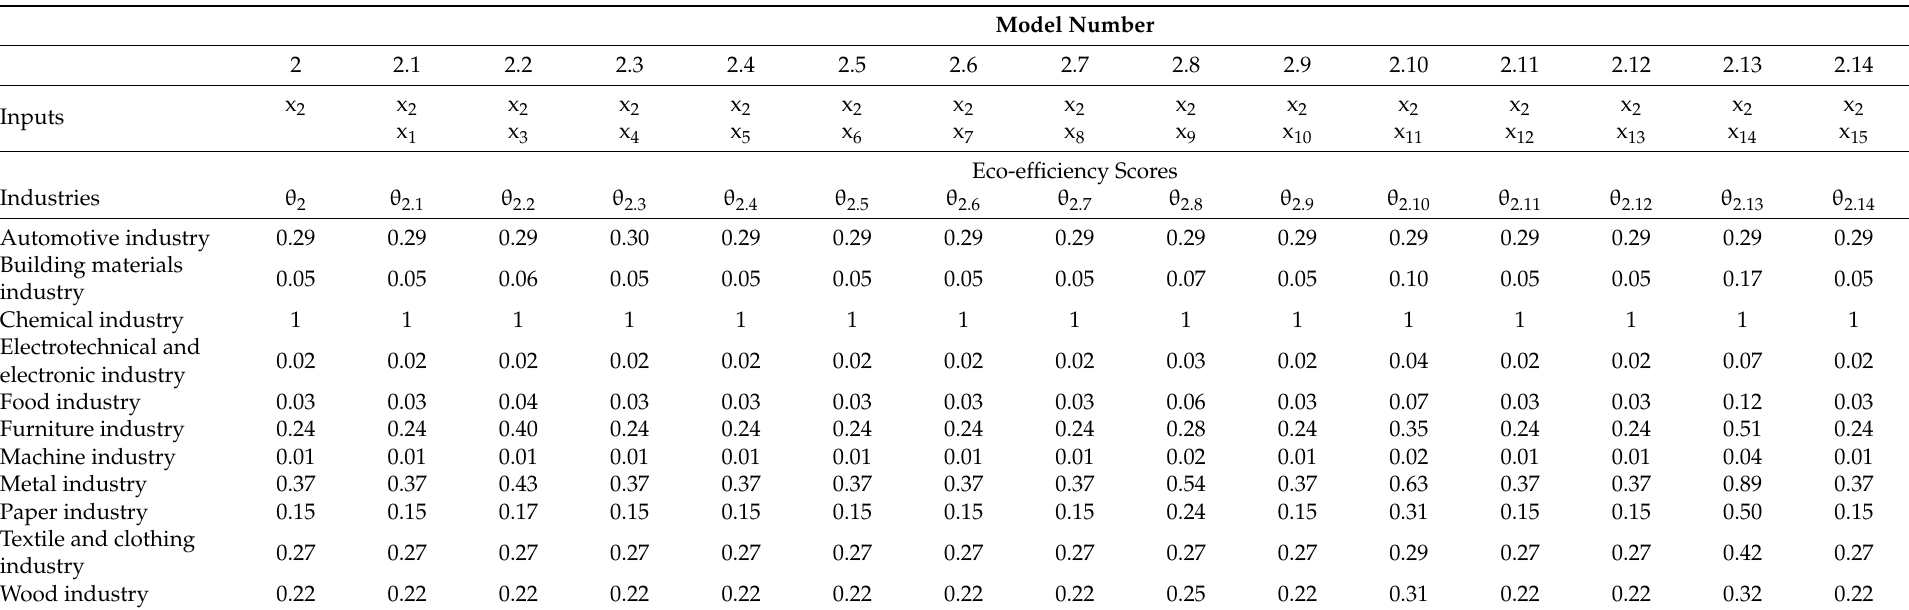
Table 2. Eco-efficiency scores obtained from the full models 2.1–2.14 and the reduced model